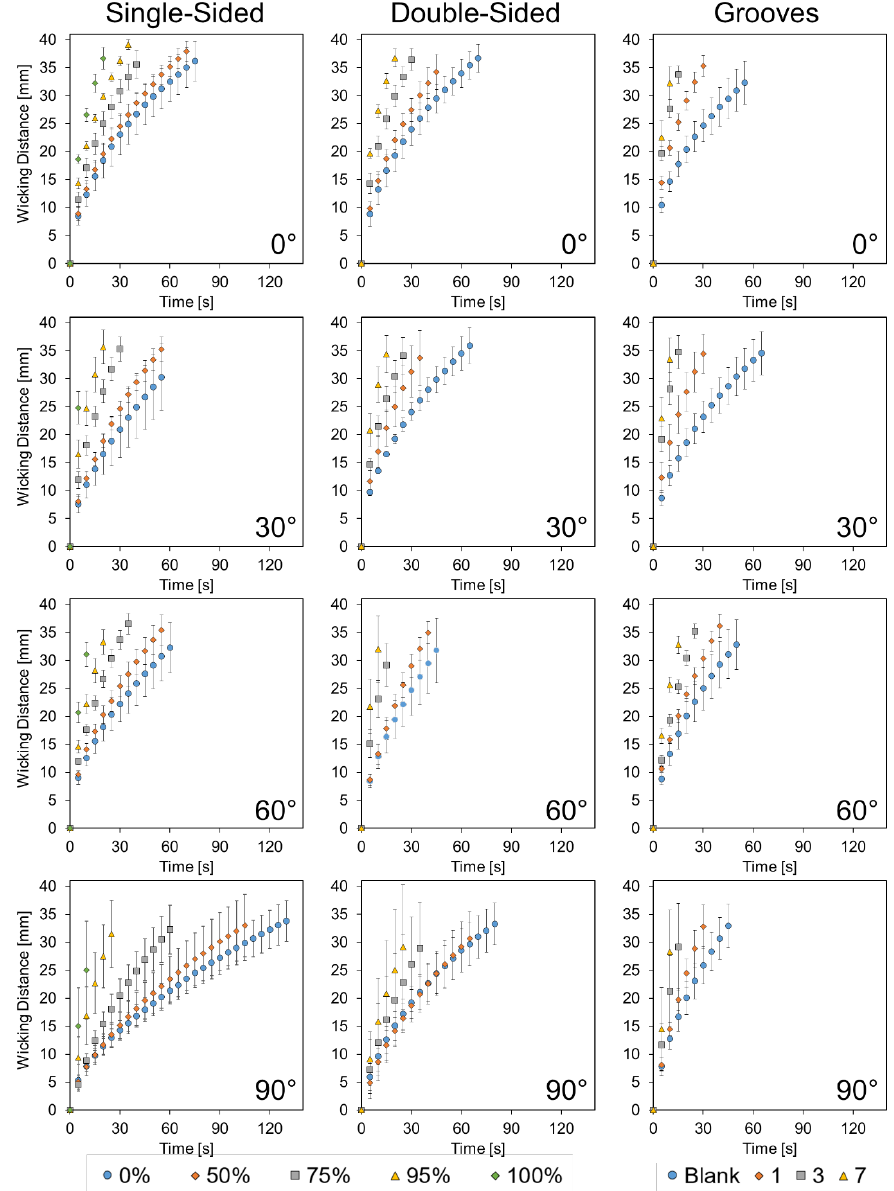
Figure A8. Distance vs. time plots for taped (double-sided) angled wicking. Data presented as mean ± SD. n = 5.